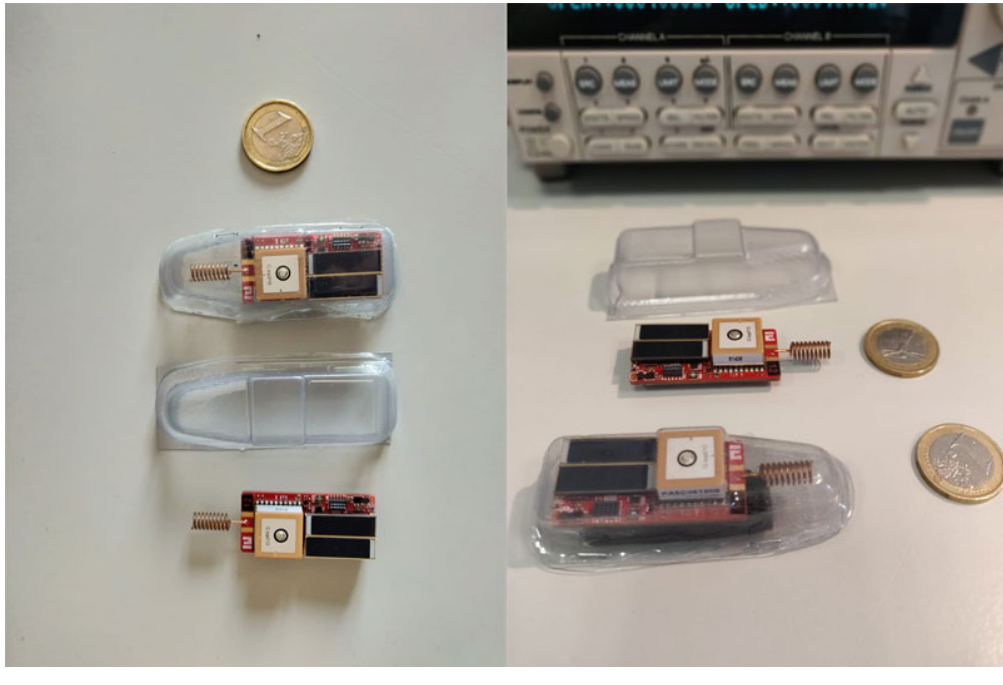
Figure 4. WSN inside and outside the packaging.